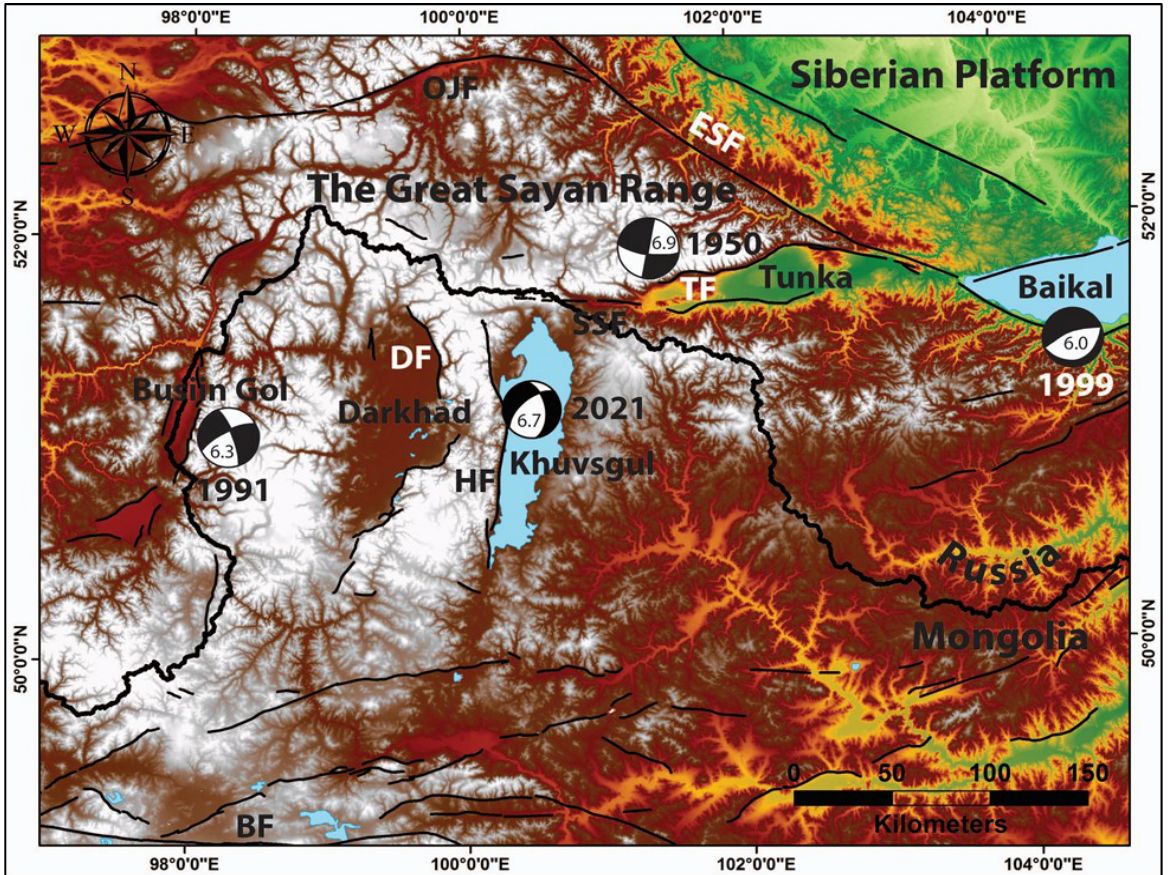
Fig. 1. General map of the Busiin Gol, Darkhad, Khuvsgul, Tunka at south-western edge of the Baikal rift system. Focal mechanisms of earthquakes (M ≥ 6.0) and active faults are plotted on Shuttle Radar Topography w Mission (SRTM). Elevations are from ~500 (light-green) to ~3500 m (white). The thick curved black line is the border between Mongolia and Russia. The focal mechanism solutions for M ≥6.0 events are from Bayasgalan et w al. (2005) and Ritz et al. (2018). Black lines represent the active faults, including Khuvsgul fault (HF), South Sayan fault (SSF), Darkhad fault (DF), Busiin Gol fault, Oka-Jombolok fault (OJF), Eastern Sayan fault (ESF) and Bulnai